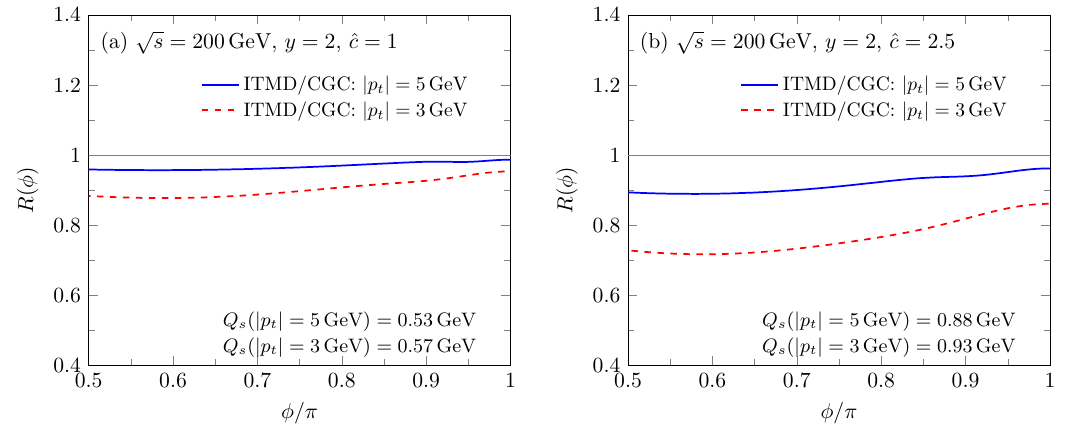
Figure 9 . Comparison of the ITMD/CGC ratio R in (a) p + p collisions and (b) p + A collisions √ at y = 2 at s = 200 GeV. The results for | p t | = 5 (3) GeV are shown in blue solid (red dashed) lines. The Q s value determined by TMDs is shown in each